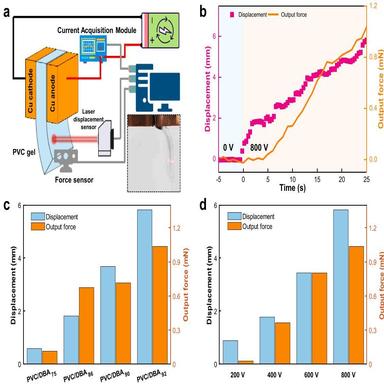
Actuation performance of PVC gel actuator. Electrically stimulated response testing system consisting of a PVC gel actuator, power supply, displacement sensor, force sensor, and current sensor (a). The inset at the bottom right corner of Fig. 6a shows a photo of the actuator bending. Displacement-time and output force-time curves of PVC gel during electrical stimulation (b). After 25 s of electrical stimulation, the displacement and output force of PVC gel were compared with different plasticizer content (c